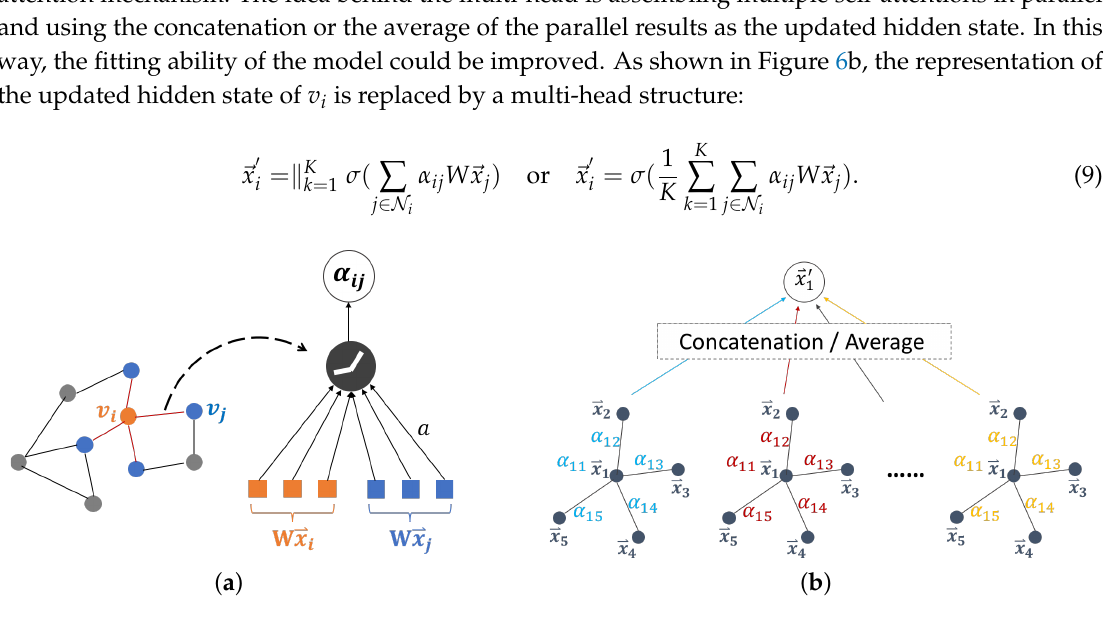
Figure 6. Inner Operations in OD-GAT. ( a ) Process to generate attention weight α ij . ( b ) Process to generate the new node feature (cid:126) x (cid:48) i